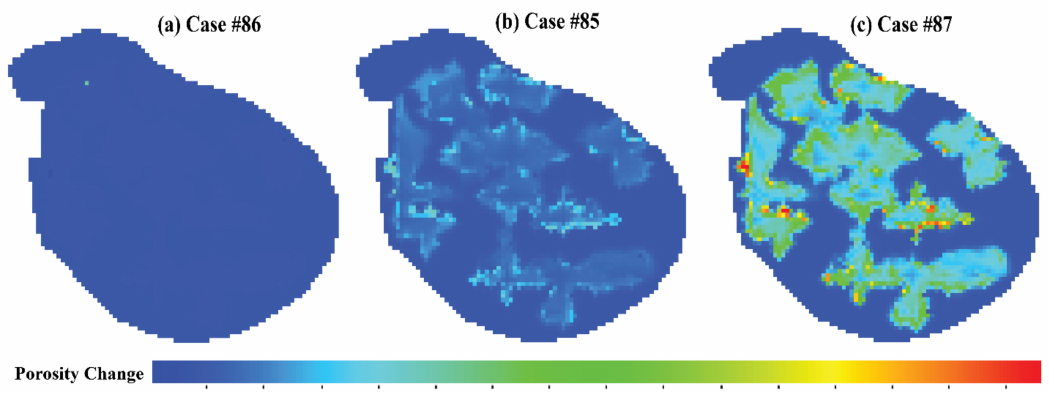
Figure 9. Estimated porosity loss at the end of the simulation period compared to the initial values for ( a ) Case #86, ( b ) Case #85, and ( c ) Case